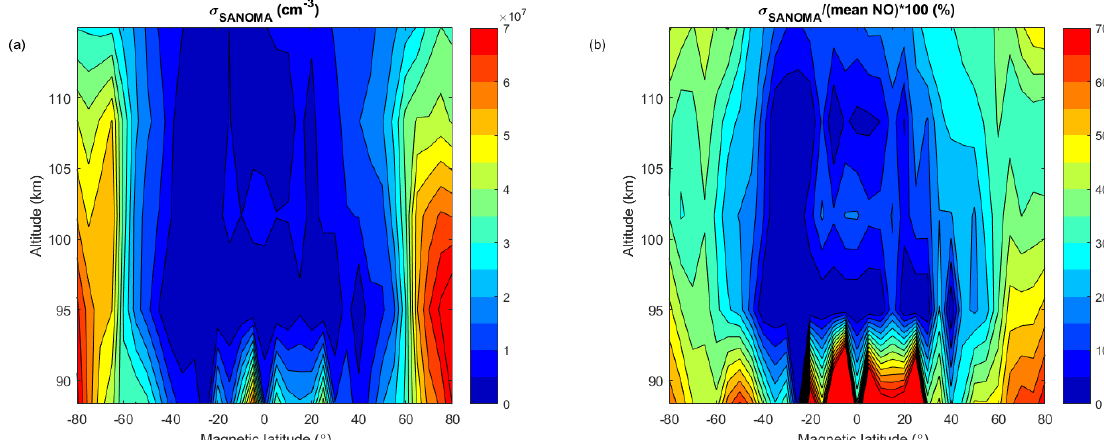
Figure 12. (a) Standard deviation of the modeling error. (b) Standard deviation of the modeling error relative to the mean